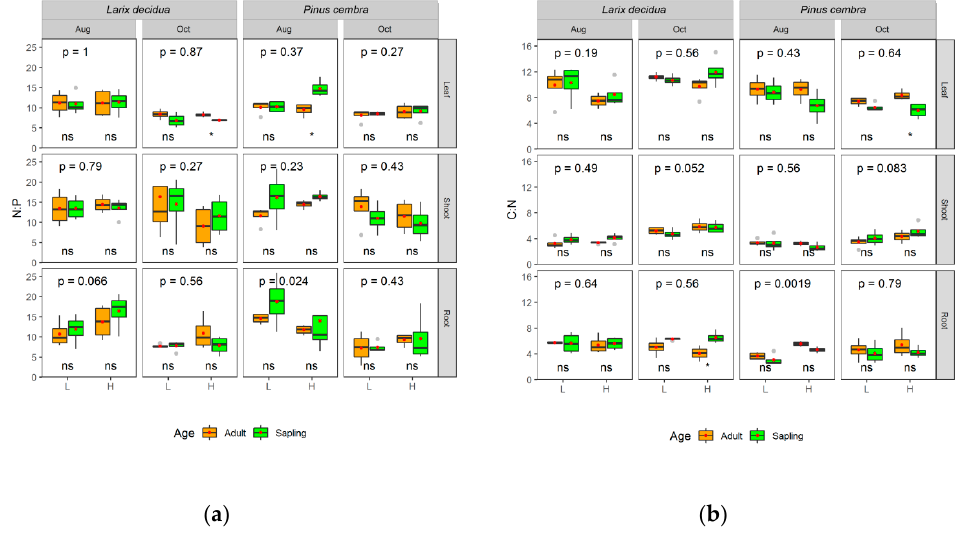
Figure 5. The ratio of N to P ( a ) and the ratio of C to N ( b ) (mean ± SE, n = 4) across tissues of the two species ( Pinus cembra L. and Larix decidua Mill.), age (sapling and adult trees), altitude (L for timberline and H for treeline), season (August for mid-growing season and October for late season) and tissues (current-year leaf, shoot, and fine root). Asterisks or “ns” at the bottom of subplot indicate significant ( p < 0.05) or non-significant ( p > 0.05) di ff erences between saplings and adults within the same altitude and season, and the p -value at the top of subplot denote significance level by the Wilcoxon’s mean test between L and